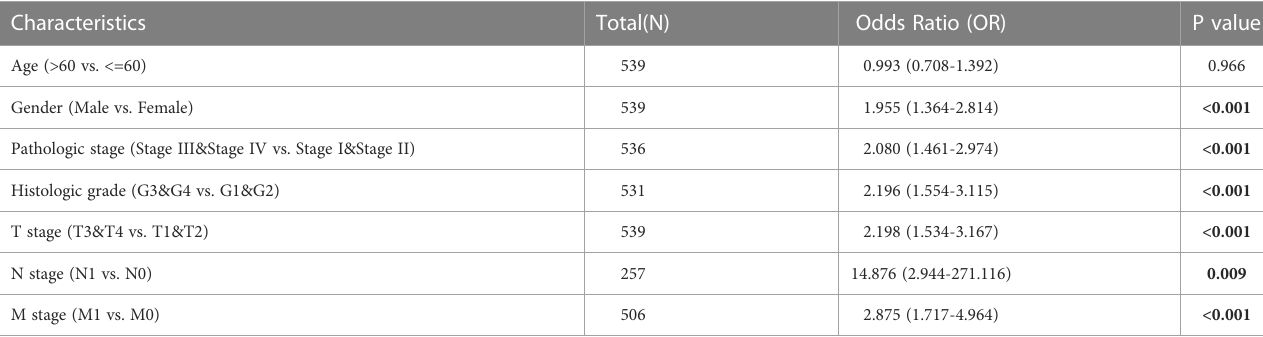
TABLE 4 Logistic regression analysis of prognosis and clinical pathological characteristics of patients.